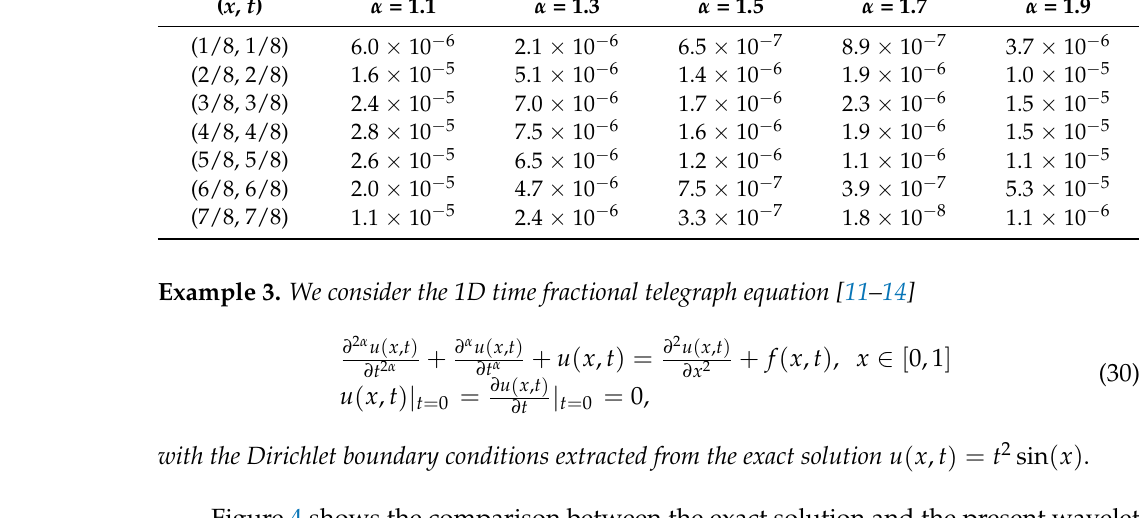
Figure 4 shows the comparison between the exact solution and the present wavelet